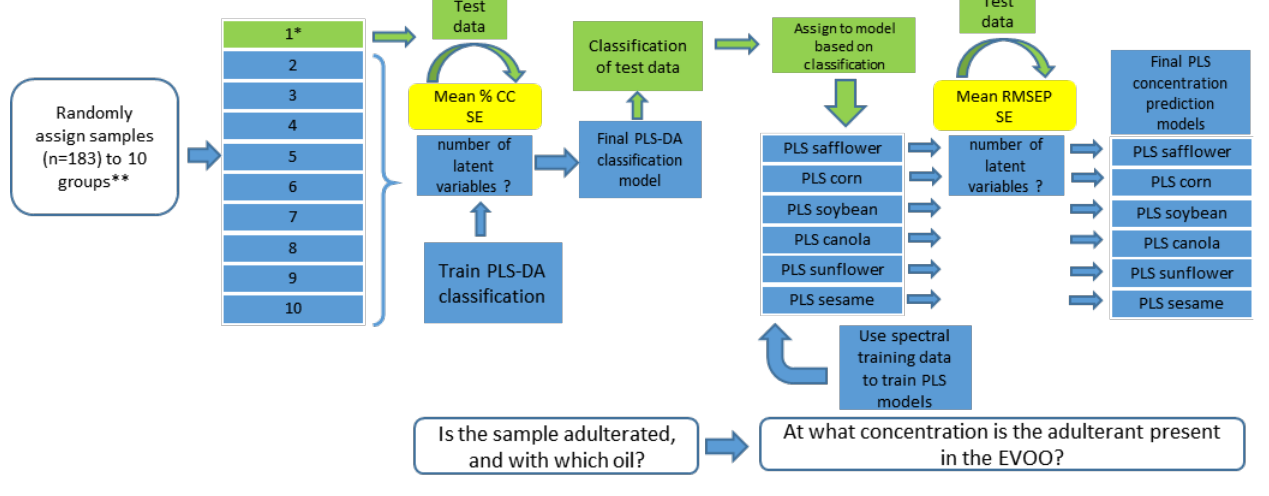
Figure 2. PLS model construction flow for the classification and quantification of the concentration of adulterants in EVOO; * the process for partition 1 is repeated for partitions 2 to 10 so that every partition is the test set once; ** randomly assigning samples is done 10 times (10 times 10 partitions are made); CC = correct